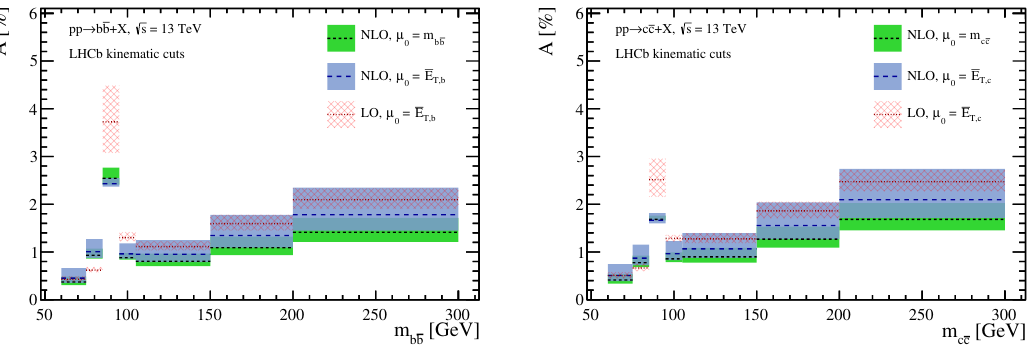
Figure 6 . Di(cid:11)erential asymmetries for b - (left) and c -jet (right) pairs within the LHCb accep- p tance (2.2) at s = 13 TeV. The NLO (LO) results have been obtained for (cid:22) 0 = m (cid:22) 0 = E T;Q ( (cid:22) 0 = E T;Q ), and the shown error bands correspond to scale